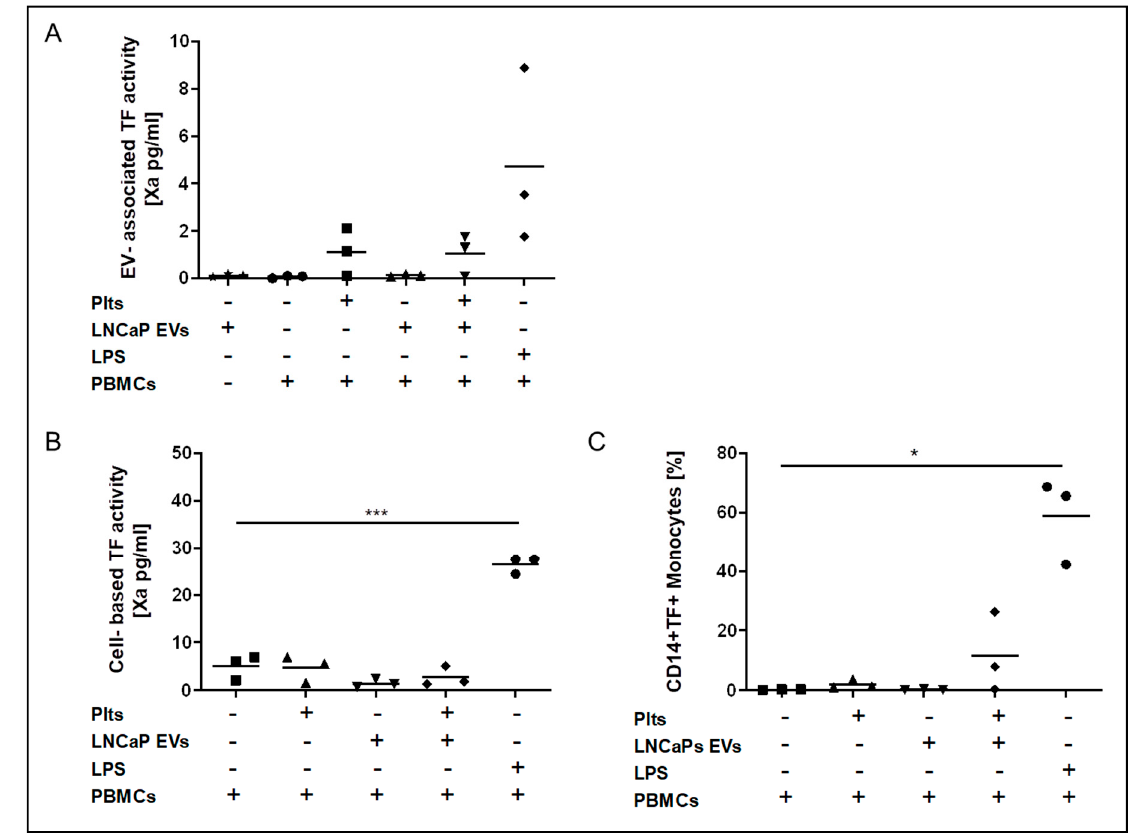
Figure 5. Co-incubation of conditioned media from TF-low LNCaP prostate cancer cells with PBMCs and platelets. EV-associated TF activity ( A ), cell-based TF activity ( B ), and TF expression on monocytes ( C ) did not change significantly when PBMCs were co-incubated with EV from LNCaP cells compared to PBMCs alone in the presence and absence of platelets. Each dot represents a single measurement, and the line represents the mean. (* p < 0.05, *** p ≤ 0.001, paired comparison for repeated measurements).